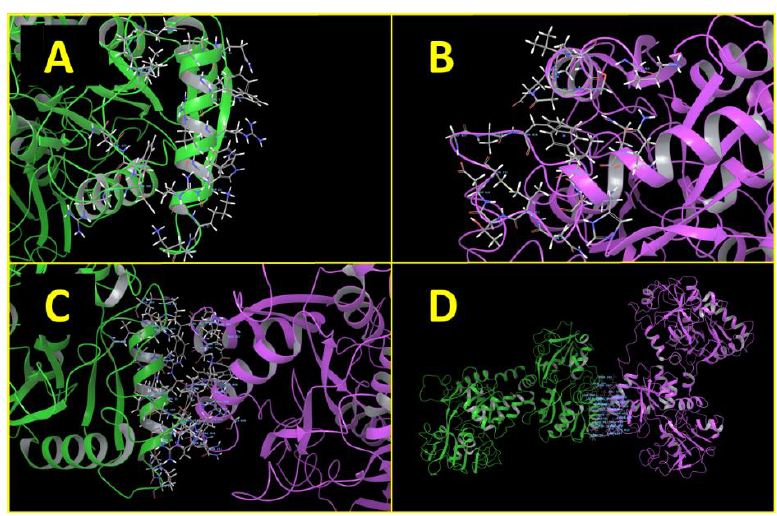
Figure 2. Molecular docking studies revealed that Lf possibly attaches to Tf and exhibits variable binding with various amino acids: ( A ) Transferrin (Tf) structure, ( B ) Lactoferrin (Lf) structure, ( C ) amino acid interactions among the Lf and Tf proteins and ( D ) docked Lf-Tf protein complex. Table 1. Distance between different amino acids of Lf and Tf, along with the chemical configuration. Tf Residues Tf